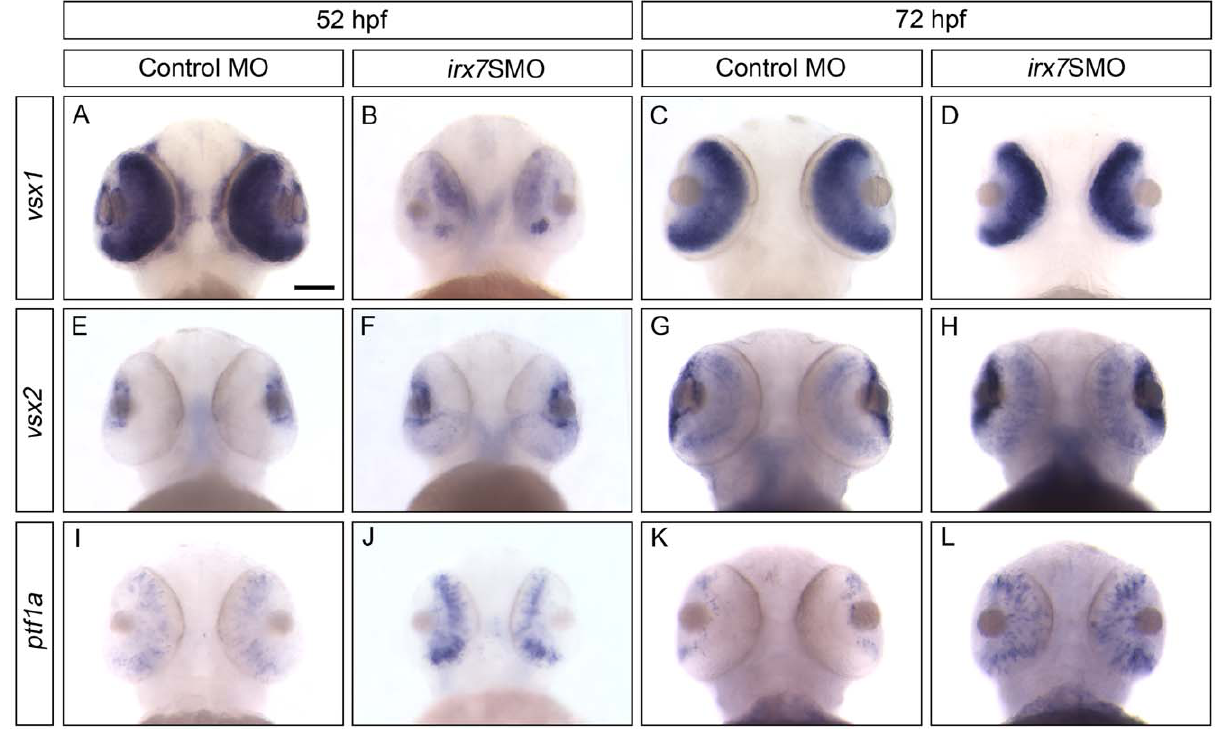
Figure 8. Irx7 regulates the expression of TFs that specify retinal cell types in INL at 52 and 72 hpf. Whole-mount in situ hybridization of vsx1 (A–D), vsx2 (E–H), ptf1a (I–L) was conducted. The most common staining pattern is shown. Embryos were imaged from the ventral side and anterior is up. See text for further discussions. The results for neurod , a TF that specifies cells in both INL and ONL, will be presented in Figure 9. Scale bar=50 m m.